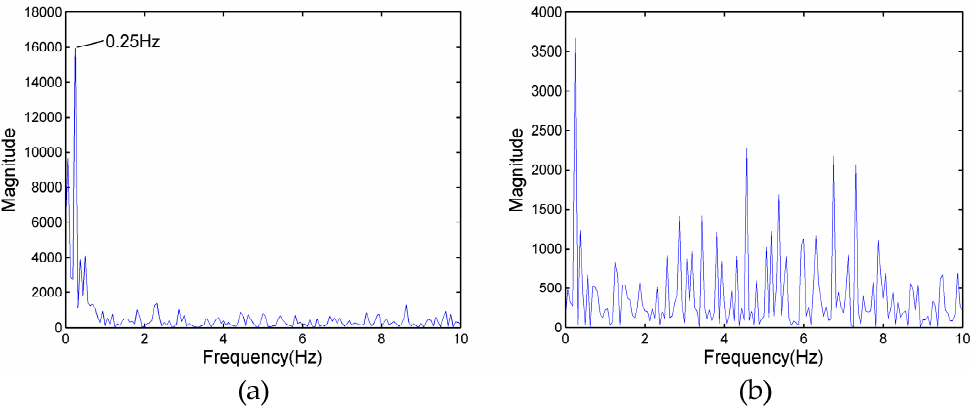
Figure 5. ( a ) The frequency spectrum of target B in Figure 3a; and ( b ) the frequency spectrum at the same distance as target B of Figure 3a in Figure 3c.